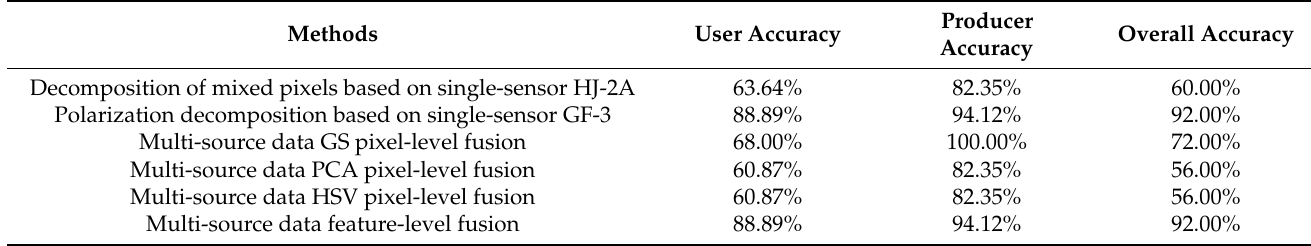
Table 4. The accuracy of sandy land detection based on field data.